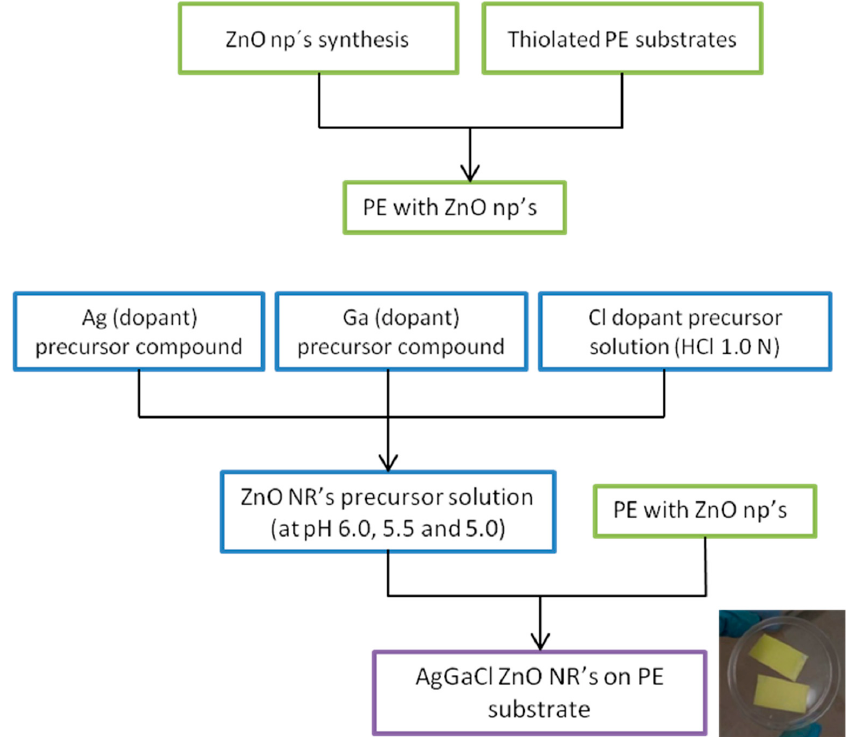
Figure 7. AgGaCl-doped ZnO NRs general synthesis diagram.